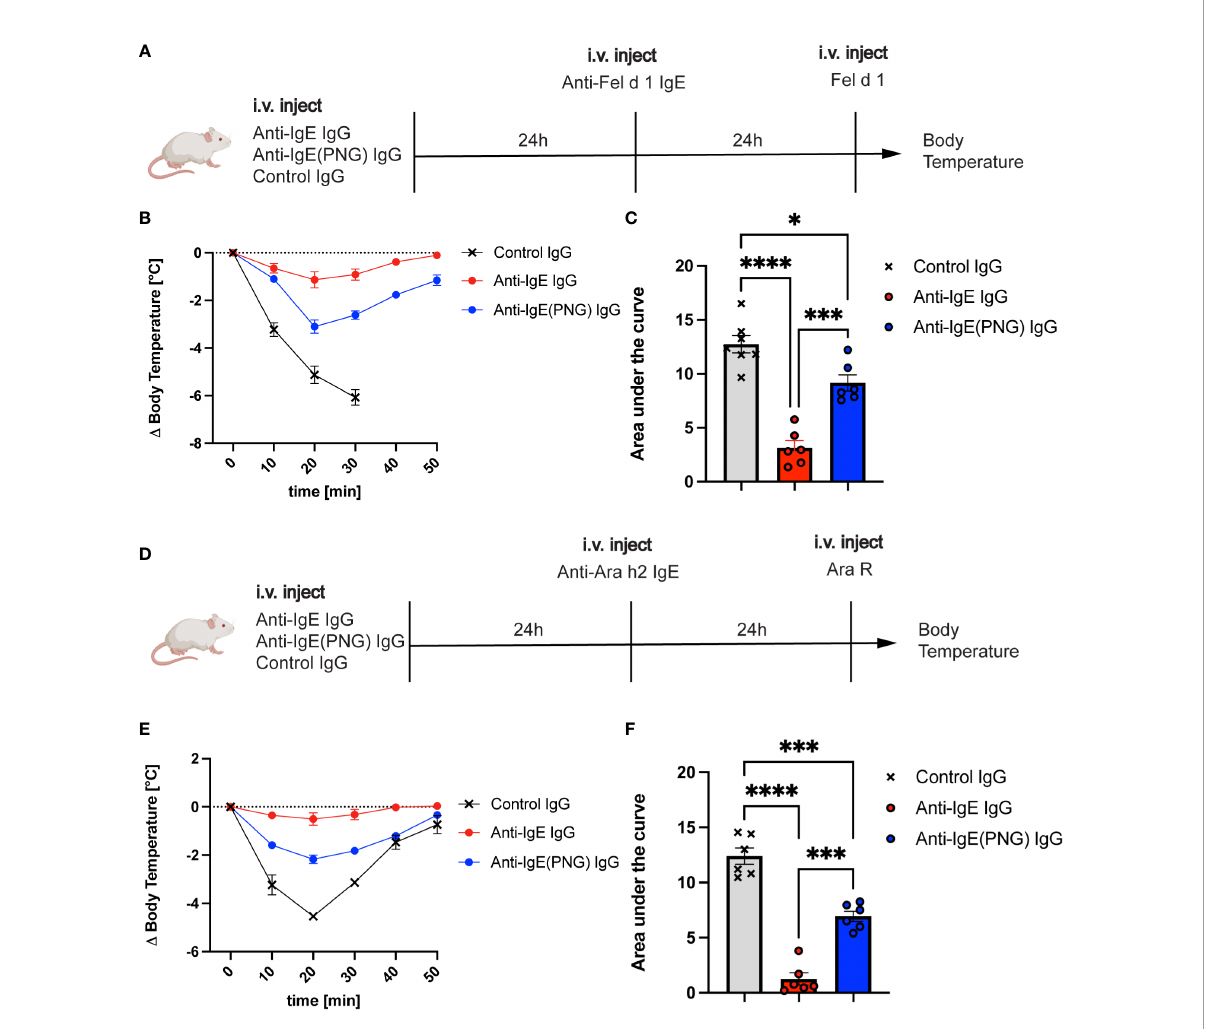
FIGURE 3 Passive immunization with anti-IgE-IgG protects against allergen challenges. The schematic overview of challenges with Fel d 1 and Ara R as an allergen in Balb/c mice (A, D) . Decrease in body temperature (delta) over time following challenge with Fel d 1 after passive immunization with anti-IgE IgG, anti-IgE(PNG) IgG, or control IgG (B) . The area under the curve of the challenge with Fel d 1 (C) . Decrease in body temperature (delta) over time upon challenge with Ara R after passive immunization with anti-IgE IgG, anti-IgE(PNG) IgG, or control IgG (E) . The area under the curve of exposure to Ara R (F) . Statistical analysis (mean ± SEM) with one-way ANOVA (C, D) . n = 6 from 2 independent experiments. The signs for statistical signi fi cance are p ≤ 0.05 (*), p ≤ 0.001 (***), and p ≤ 0.0001